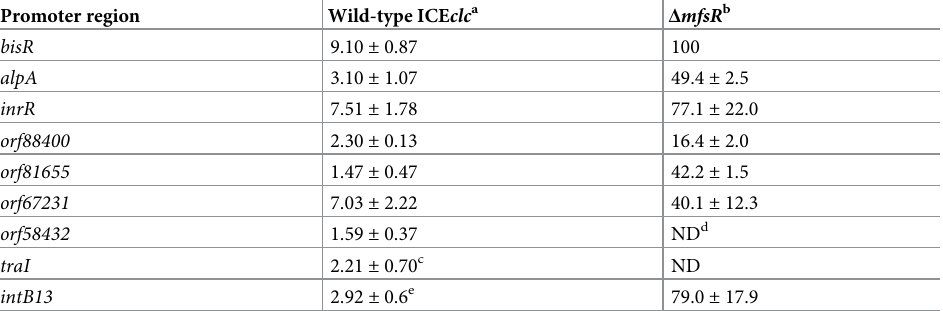
Table 1. Proportion of stationary phase P . knackmussii B13 or P . putida ICE clc cells expressing eGFP fluorescence from single-copy integrated bistable ICE clc promoter reporter